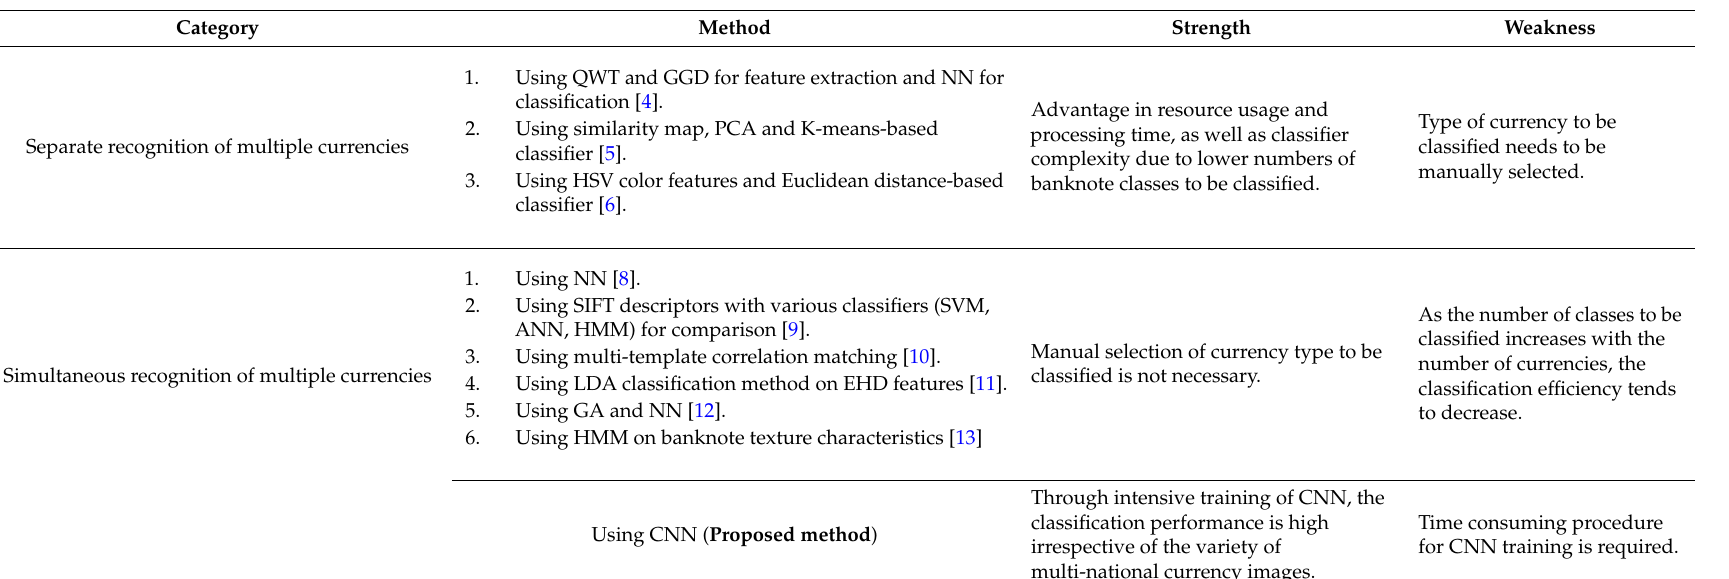
Table 1. Comparison of proposed method and related works on multi-national banknote